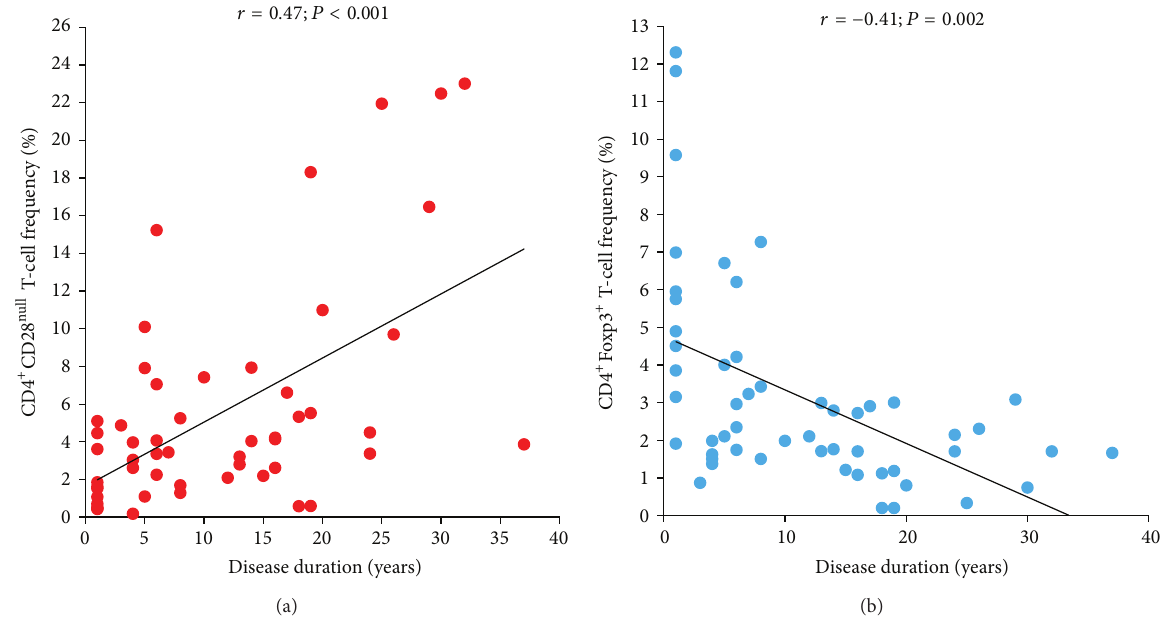
Figure 5: Correlation between T-cell subsets and disease duration in T2DM patients. T2DM patients were defined as in Figure 1. Data are presented as single data points. (a) CD4 + CD28 null T-cell frequency positively correlates with disease duration in T2DM patients. (b) CD4 + FoxP3 + T-cell negatively correlates with disease duration in T2DM patients.